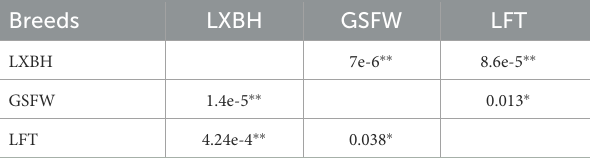
TABLE 3 Chi-square test of HIAT1 P3-ins-9bp genotype distribution in the three sheep breeds. Breeds